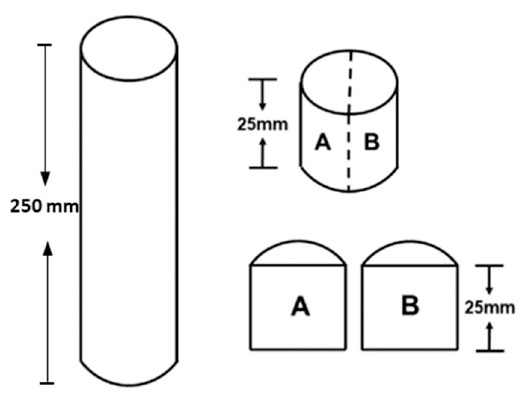
Figure 1. Obtention of probes for metallographic measurements.